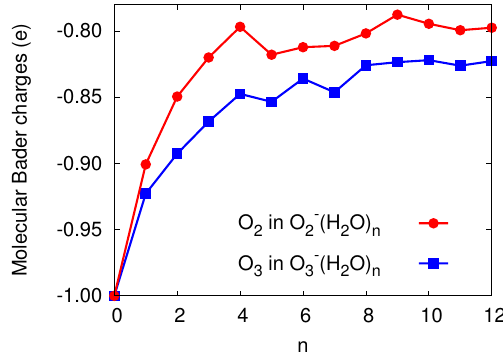
( H 2 O ) 8 cluster. Hydrogen 2